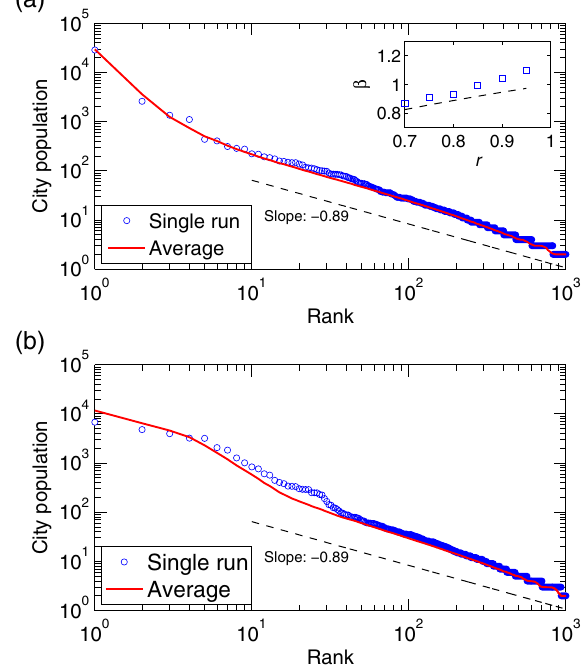
FIG. 2 (color online). Rank-population plot for a single configuration and for the proper average over 100 runs when the network starts with two nodes (a) and when the network starts with ten interconnected nodes uniformly spread in the spatial domain (b) (see Sec. IV). Dashed lines indicate the predicted slope of the tail for r ¼ 0 . 8 of the simulations shown. The fitted slope of the tail of the rank-population curve (for cities of rank ≥ 10 ) is − 0 . 930 , with R 2 > 0 . 94 and the 95% confidence interval of ½ − 0 . 938 ; − 0 . 922 (cid:1) , for panel (a). The inset in (a) shows the measured exponent as a function of r and is compared to the theoretical prediction of Eq. (7). Note, in particular, that the Zipf exponent − 1 can also be achieved for some value of r ≈ 0 . 85 . The grid used for the CCA algorithm has M ¼ 225 divisions, ≈ 1 corresponding to n th